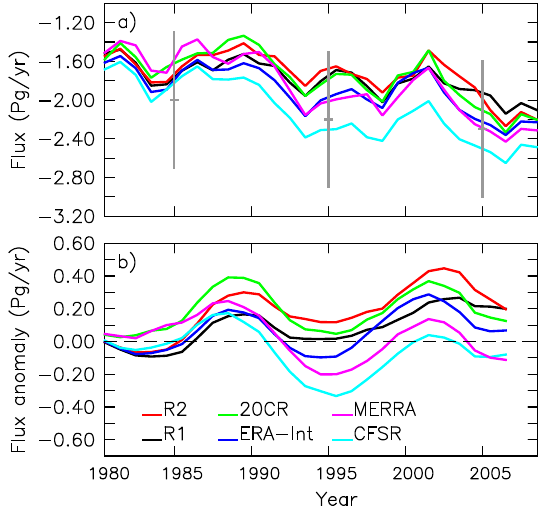
Figure 9. (a) Global net sea–air flux of CO 2 since 1980 for six runs with different reanalysis winds and (b) the surface flux anomaly due to the effect of time-evolving winds, computed as the difference be- tween runs with time-evolving and fixed winds. Fluxes are positive out of the ocean. The grey bars in (a) are observational estimates of the net flux (Ciais et al.,